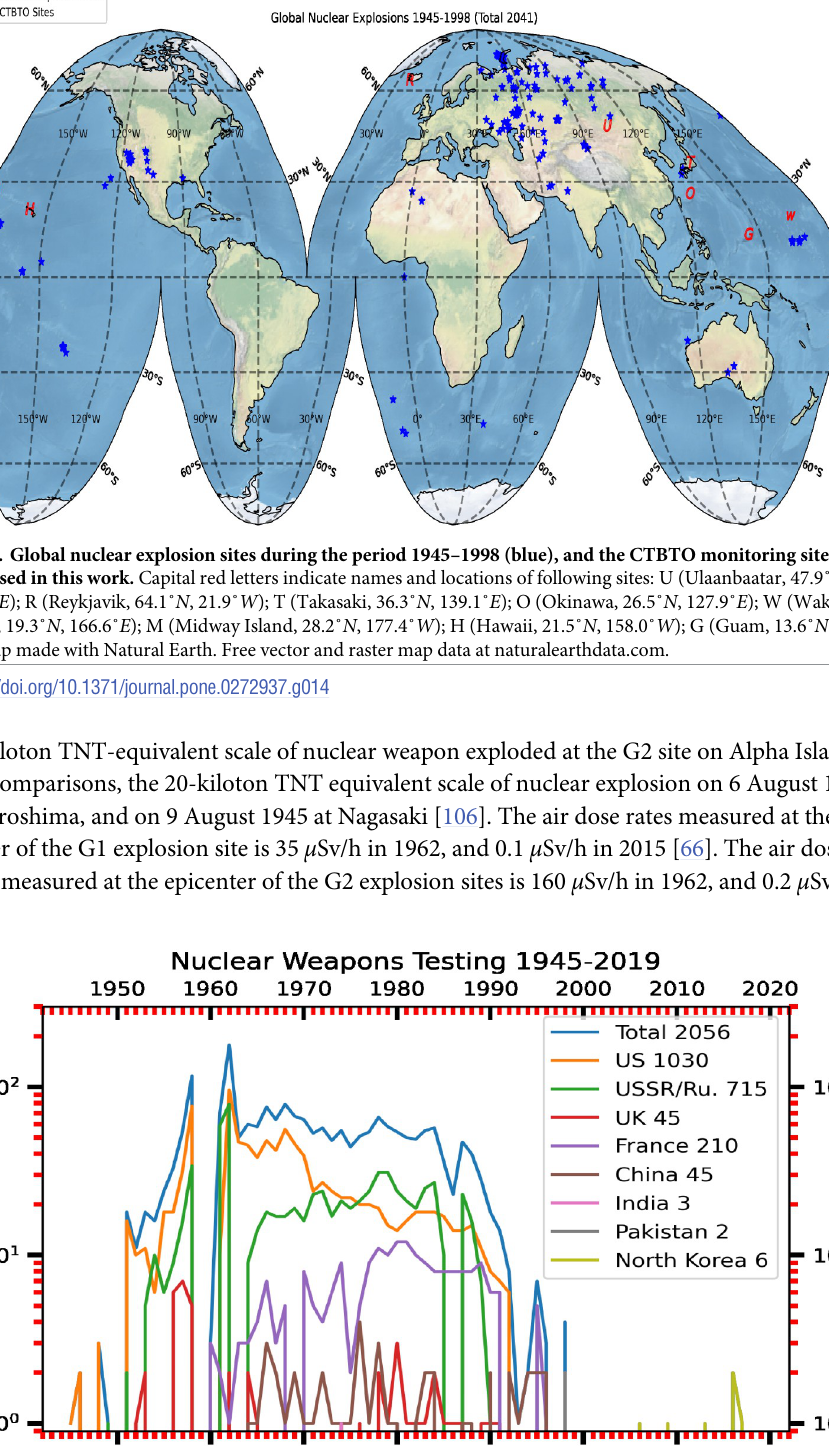
Fig 15. Annual tally of testings of nuclear weapons with respect to countries during the period